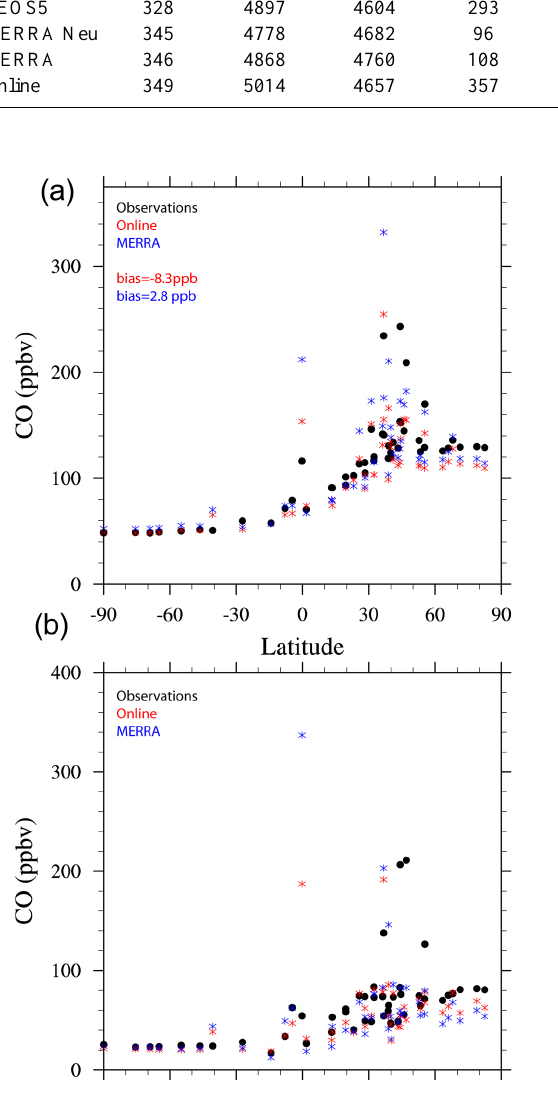
Fig. 11. (a) Comparison of the annual mean surface mixing ratio of CO to NOAA/GMD observations. (b) Comparison of the mean annual cycle (maximum minus minimum) of surface CO mixing